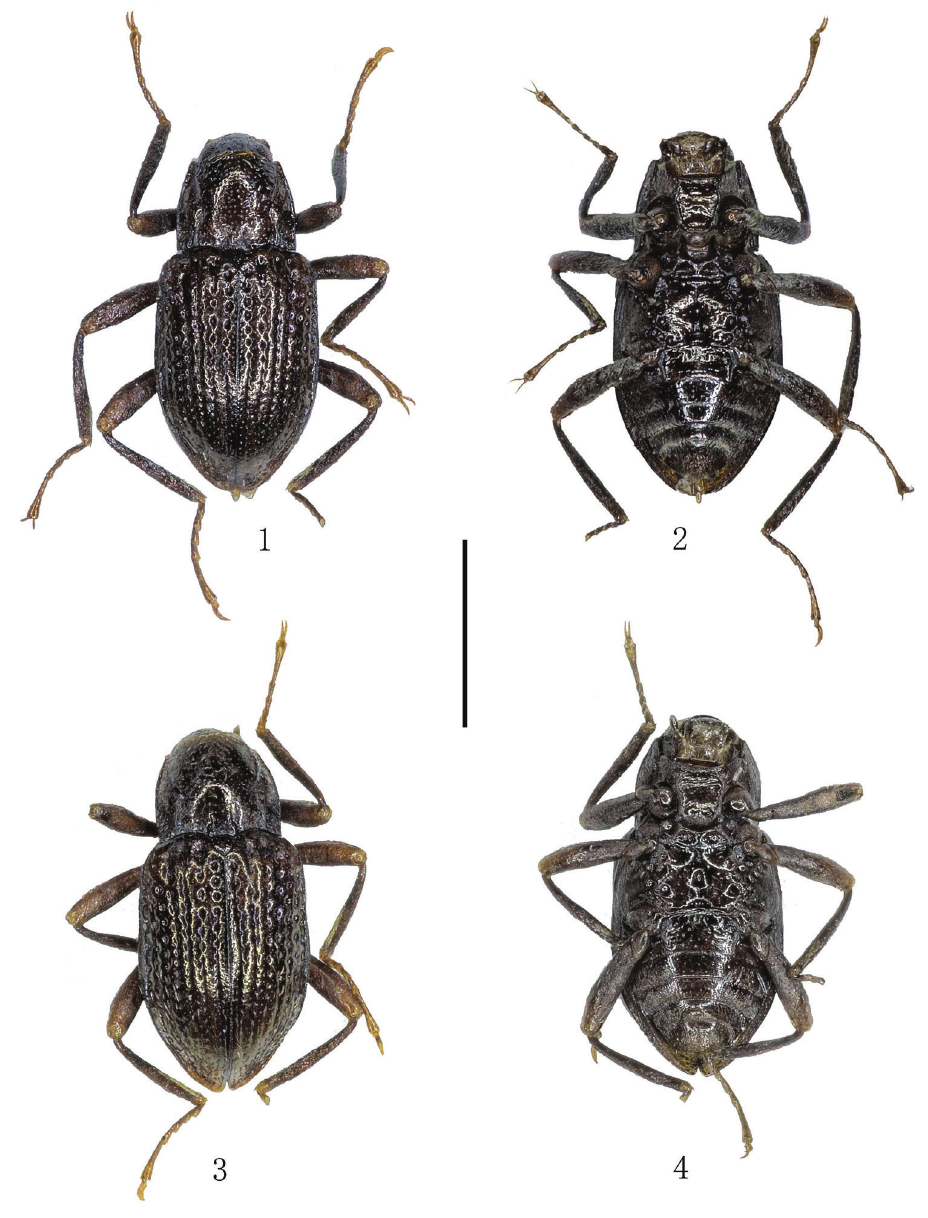
Figures 1–4. Habitus. 1–2 Grouvellinus orbiculatus sp. n., holotype 3–4 G.sagittatus sp. n., holotype 1, 3 dorsal view 2, 4 ventral view. Scale bar: 1 mm. Photograph by Dongju Bian. anteriorly; an oblique impression on each side extending from the end of carina to anterior angle. Base with two elongated oval impressions in front of anterior angles of